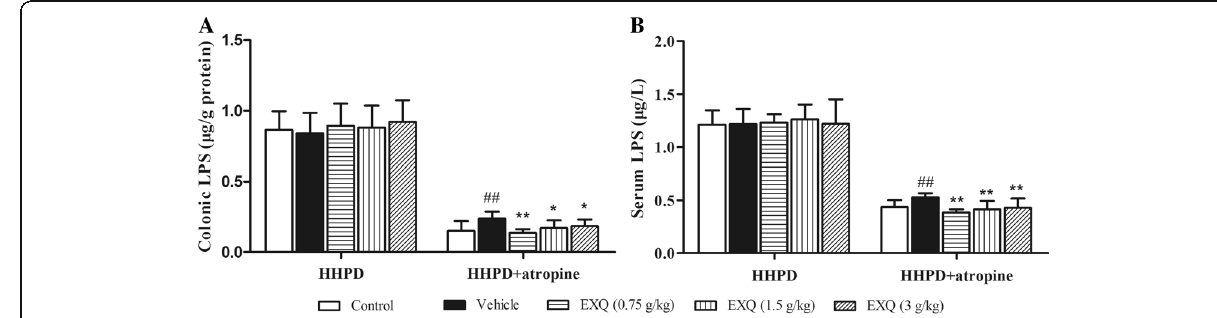
Fig. 5 Effect of EXQ on colonic and serum LPS levels in two models of experimental constipated mice. The levels of colonic LPS ( a ) and serum LPS ( b ) were determined. Data are presented as mean ± SD ( n = 8). # P < 0.05, ## P < 0.01 compared to the normal control group; * P < 0.05, ** P < 0.01 compared to the vehicle